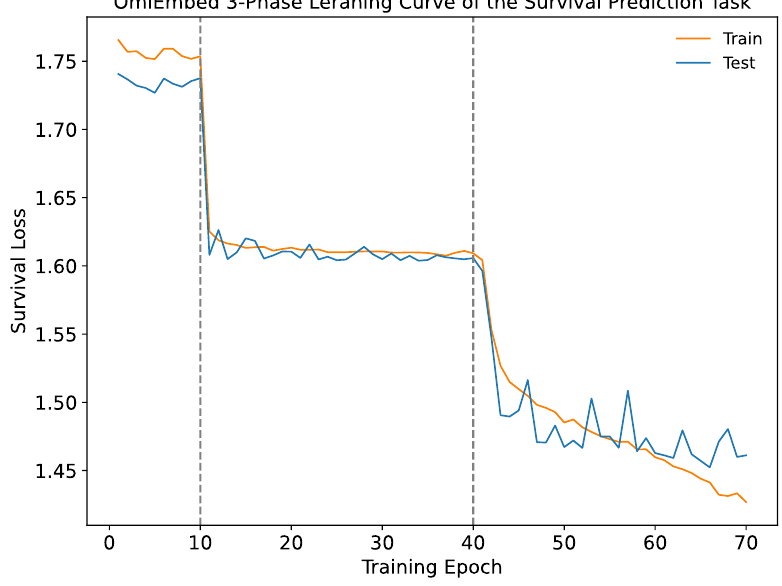
Figure 5. The learning curve of the survival prediction task with the three-phase training strategy of OmiEmbed. Epoch 1 to 10 belong to Phase 1; epoch 11 to 40 belong to Phase 2; epoch 41 to 70 belong to Phase 3.